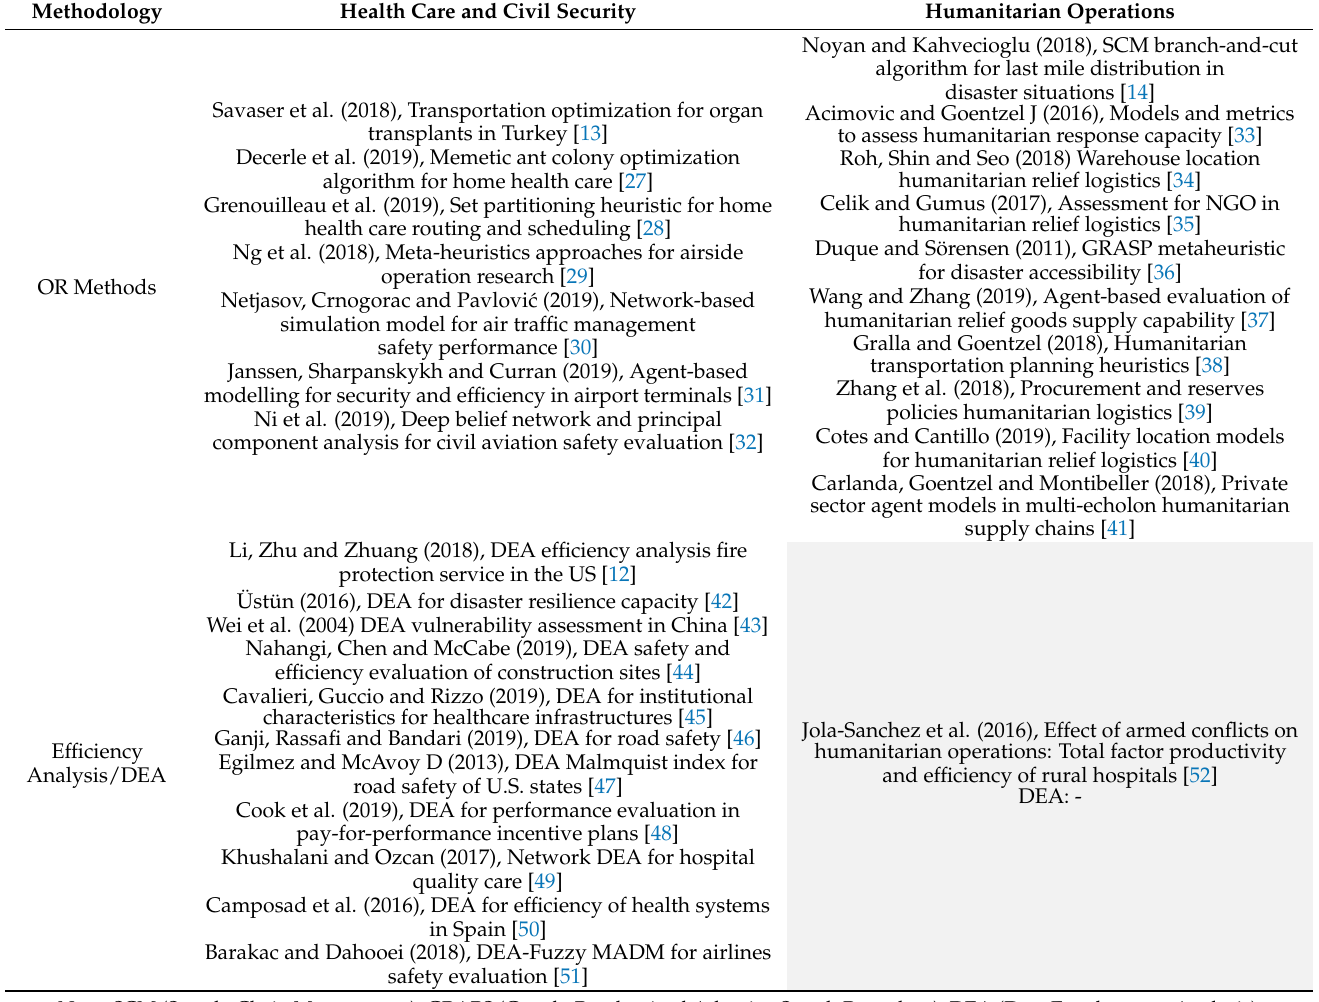
Table 2. Literature review operations research (OR) methods and efficiency analysis humanitarian operations. Methodology